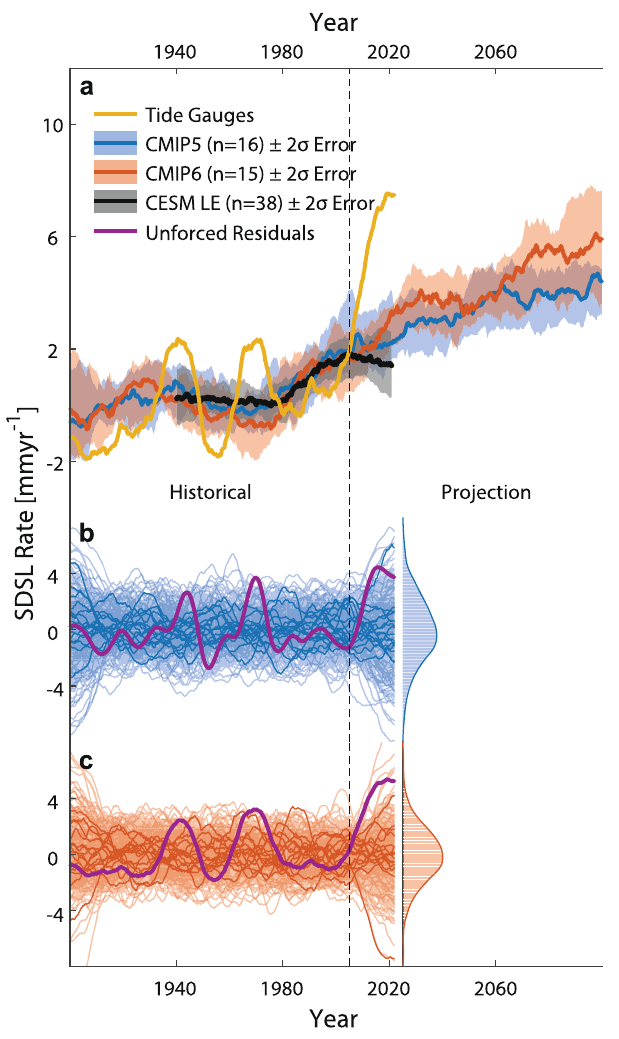
Fig. 4 | Nonlinearsterodynamic (SDSL)rates along theU.S.Southeast and Gulf coasts from observations and models. a Nonlinear rates of SDSL averaged from tide-gauge records south of Cape Hatteras after removing contributions from effects of Gravitation, Rotation, and Deformation (GRD) related to barystatic sea- level change, vertical land motion, and the inverted barometer effect. Also shown are the rates simulated by Climate Model Intercomparison Projection (CMIP) models 5 and 6 under historical and future forcing (RCP8.5 and SSP5-8.5, respec- tively) with the thick lines representing the median and shadings representing 2 σ uncertaintiescalculatedoverallensemblemembers.Alsoshownaretheratesfrom the 38-member Community Earth System Model (CESM) Large Ensemble. b Unforced residual rates after removing the median from all CMIP5 ensemble members(thicklines).Thethinlinesrepresentratevariabilityestimatedfrom1600 (1500) phase randomized CMIP5 (CMIP6) model simulations (see Methods). The probabilitydensitydistributionontherightillustratestherangeof ratesattheend of 2021 from those random samples. c Same as in ( b ), but for